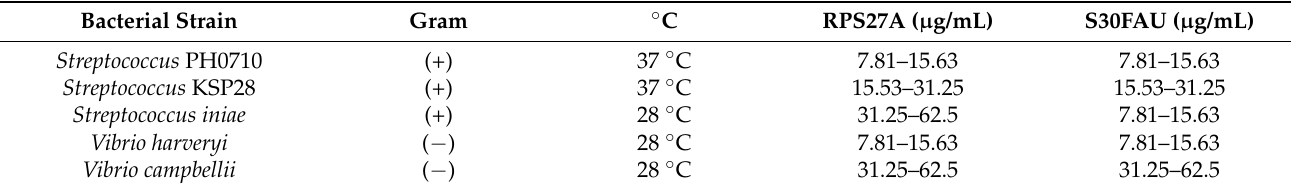
Table 3. Antimicrobial activity of RPS27A and S30FAU.